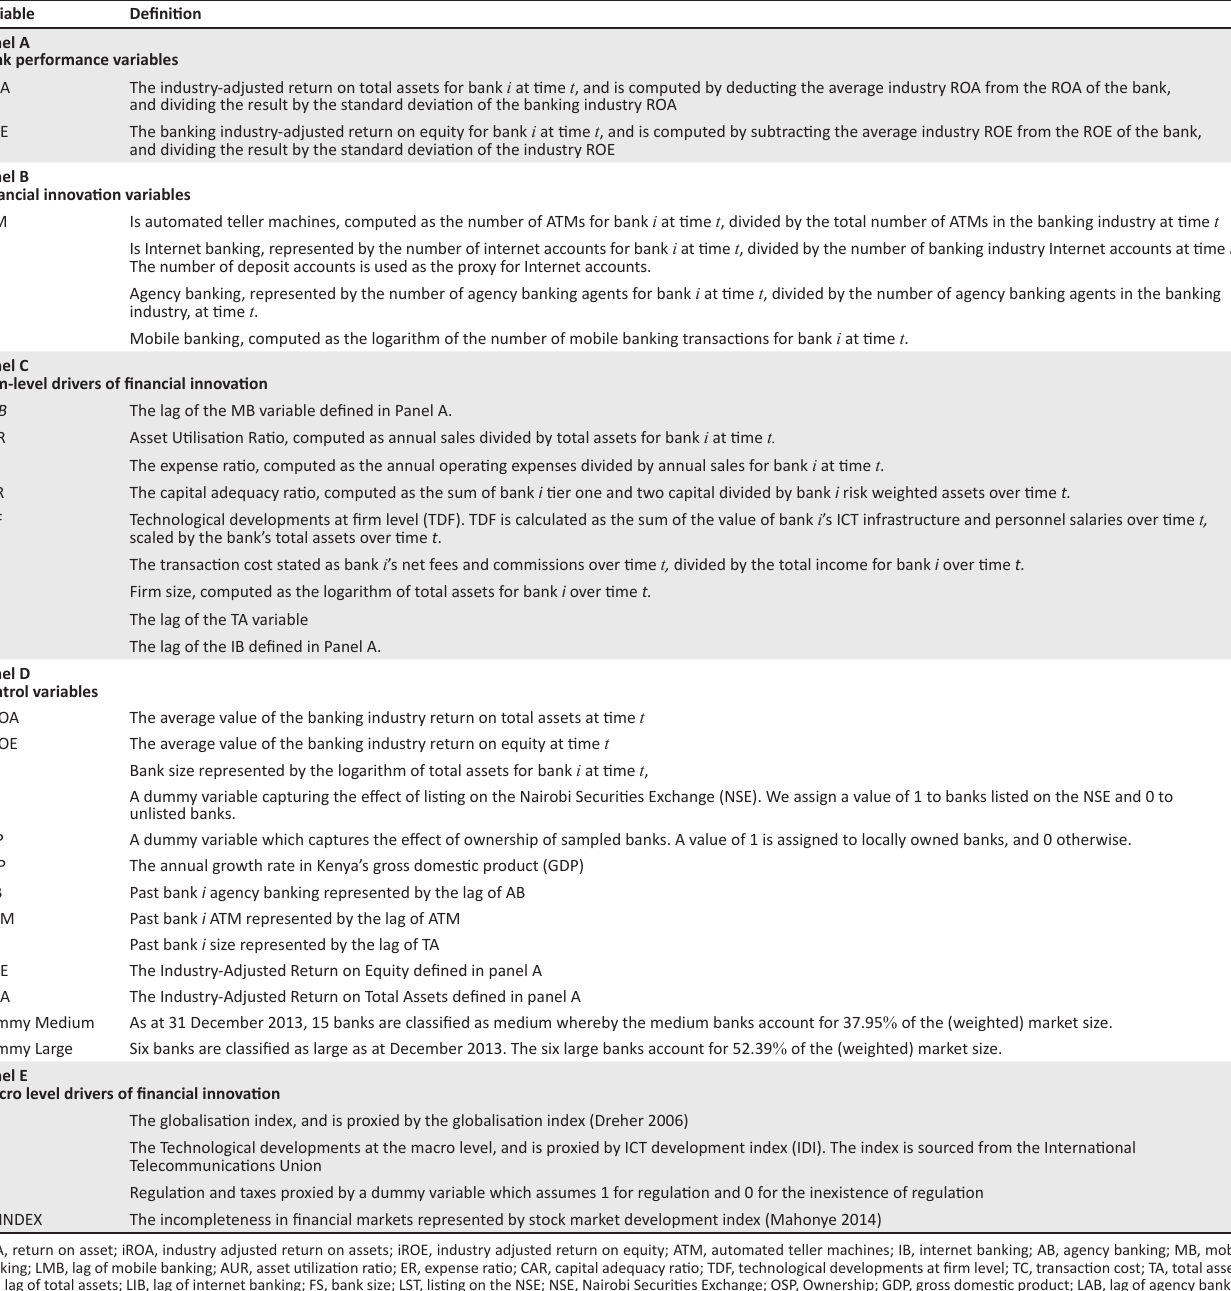
TABLE 1: Definition of